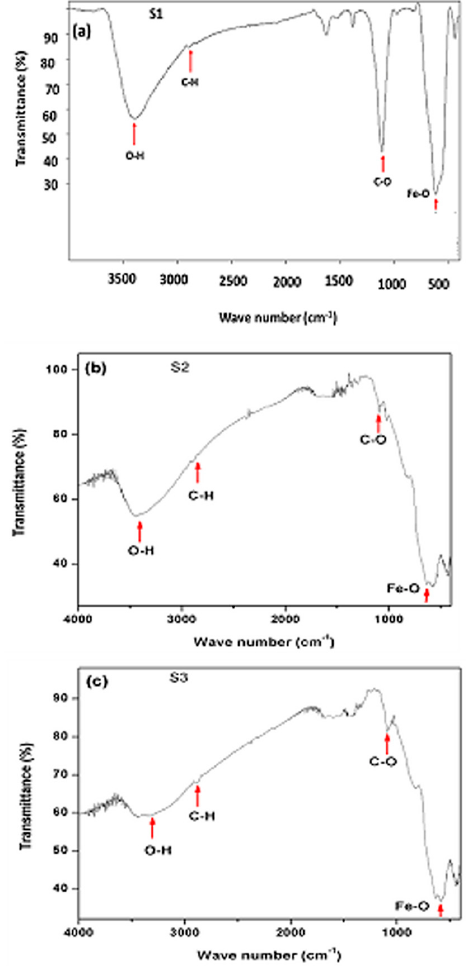
Figure 3. The FTIR spectra of the Polyethylene glycol (PEG) coatings of the samples, ( a ) for sample S1, ( b ) for sample S2, and ( c ) for sample S3. ( b ) for sample S2, and ( c ) for sample